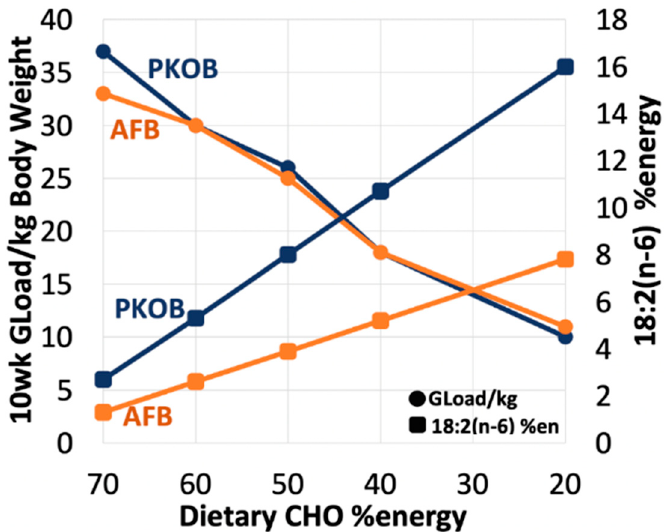
Figure 5. The GLoad (left Y-axis; dots) and dietary 18:2(n-6) intake (right-Y axis; squares) indicate the GLoad adjusted to BW decreased as CHO %energy decreased and the %energy as fat increased for all rats combined. The decrease in BW-adjusted GLoad was identical for both fats, PKOB (blue) and AFB (orange). By contrast, consumption of 18:2(n-6) was directly related to %energy from dietary fat, with the low CHO, high-fat diet providing maximum 18:2(n-6) at 16% energy for PKOB and 8% energy for AFB, both at 60% energy as dietary fat. Thus, the increase in 18:2(n-6) was twice as much for PKOB with a P/S ratio of 1.0, compared to AFB with a P/S ratio of 0.35, even though rats fed PKOB developed the most diabetes. Most (73%) diabetes for all rats occurred with diets providing 70, 60, and 50% energy as CHO, emphasizing the risk accompanying a high GLoad. Although PKOB induced 45% more diabetes overall than the AFB, the extra GLoad at 70% energy as CHO only partially explained the added risk for diabetes attributed to PKOB (see Tables S3 and S4 for details). Not surprisingly, the GLoad and cumGLoad were greatest (the latter > 200/2000